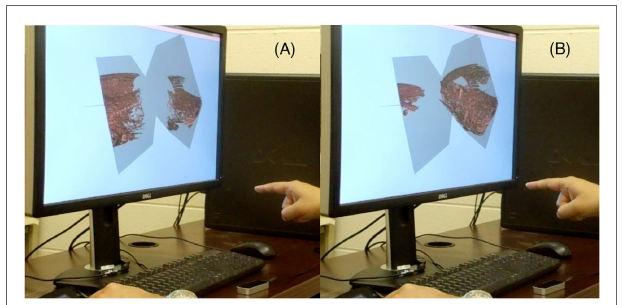
FigUre 3 | Turning the pages with BhVc – the synchronous shrinking and expanding of the sub-volumes with hand movement . (a) and (B) are two instances in this action.